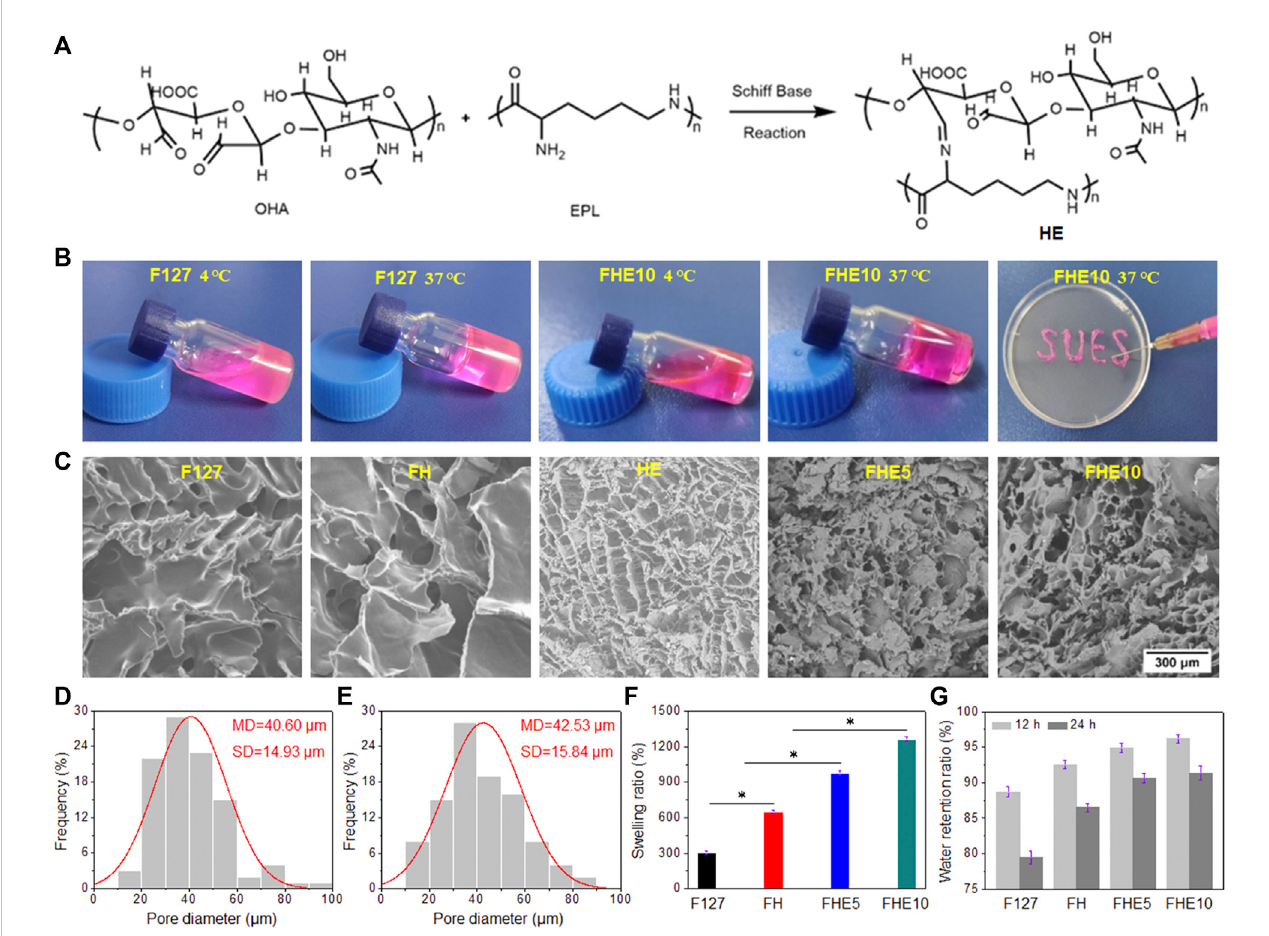
FIGURE 2 (A) Schiff base reaction mechanism route; (B) Photographs of F127 and FHE10 hydrogel before and after gelation, and FHE10 proved its injectability by extrudingSUES; (C) TheSEMimagesofF127,FH,HE,FHE5andFHE10hydrogel; (D) and (E) TheporediameterdistributionofFHE5andFHE10,respectively; (F) The swelling ratio of F127, FH, FHE5, and FHE10 hydrogel; (G) The water retention ratio of F127, FH, FHE5, and FHE10